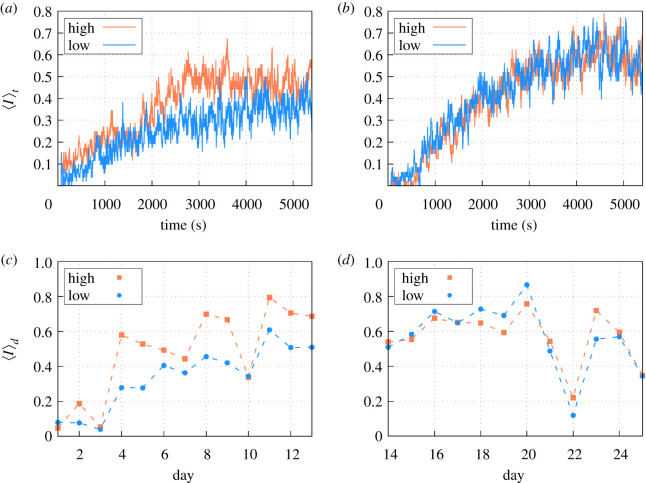
Averaged daily occupancy 〈I〉t for (a) regime A (⟨I⟩th=0.48; σ I2=0.012 and ⟨I⟩tl=0.34; σ I2=0.004) and (b) regime B (⟨I⟩th=0.57; σ I2=0.004 and ⟨I⟩tl=0.57; σ I2=0.006). Averaged occupancy split into nodes with high or low probability of containing food during (c) regime A and (d) regime B. Differences between the two types of nodes are statistically significant (T − Student test) for the regime A (⟨I⟩dh=0.48 and ⟨I⟩dl=0.34; |Ts|=4.70>T95%=0.0002) but not for the case B (⟨I⟩dh=0.57 and ⟨I⟩dl=0.57; |Ts|=0.11<T95%=0.46).